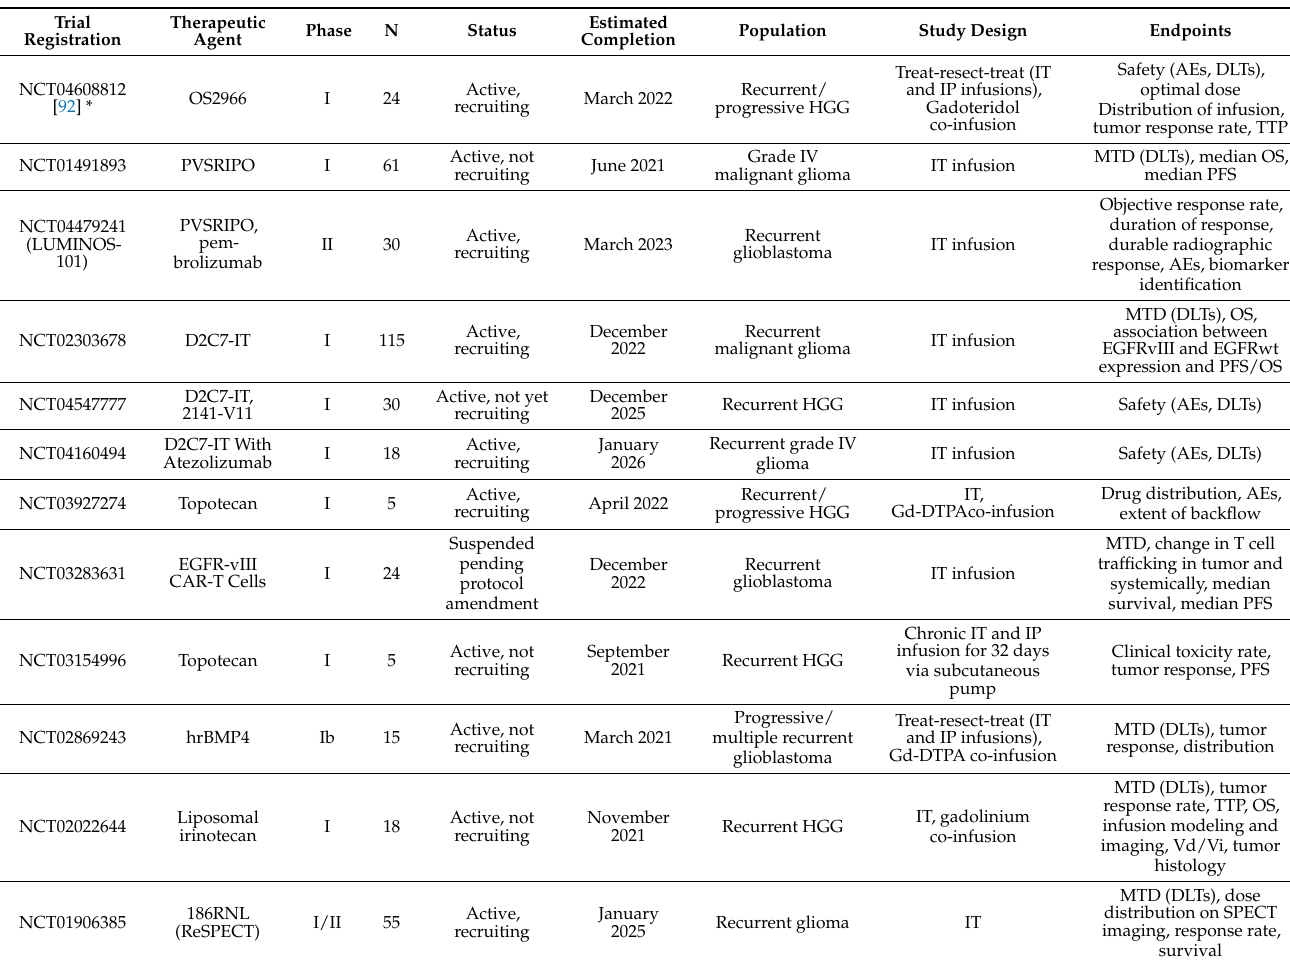
Table 2. Ongoing clinical trials utilizing convection enhanced